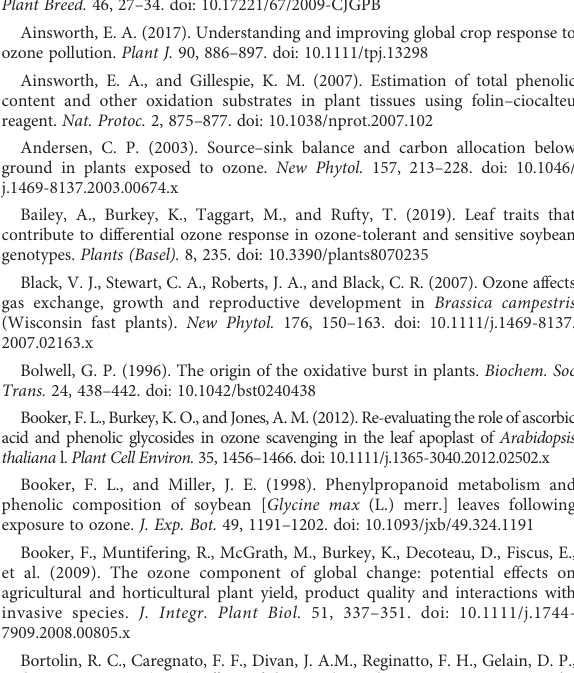
SUPPLEMENTARY FIGURE 1 The control and different ozone treatments used in this experiment.